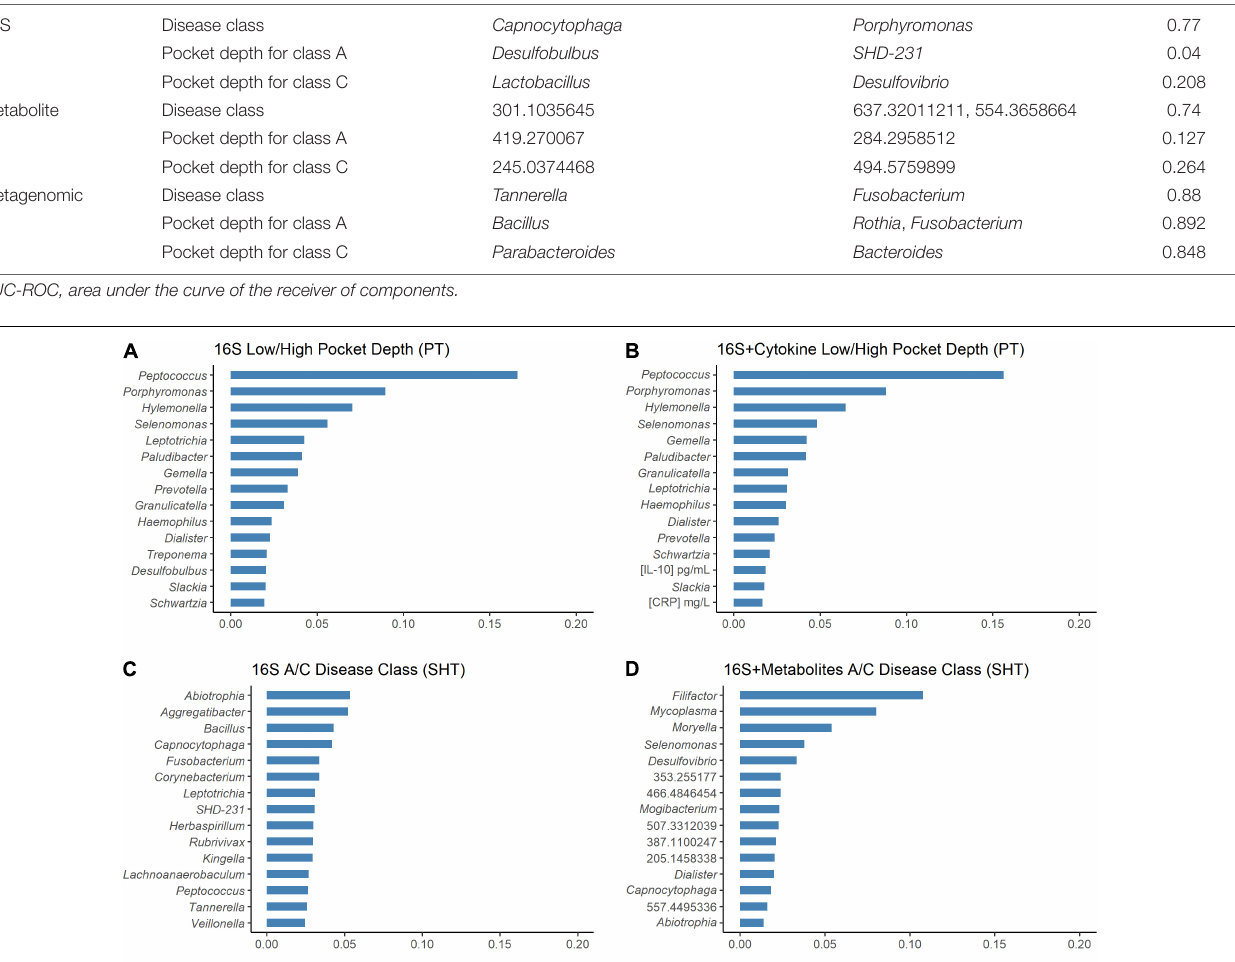
TABLE 3 | Summary of the microbial and metabolic balances generated from the sodium hypochlorite (SHT) datasets. Dataset